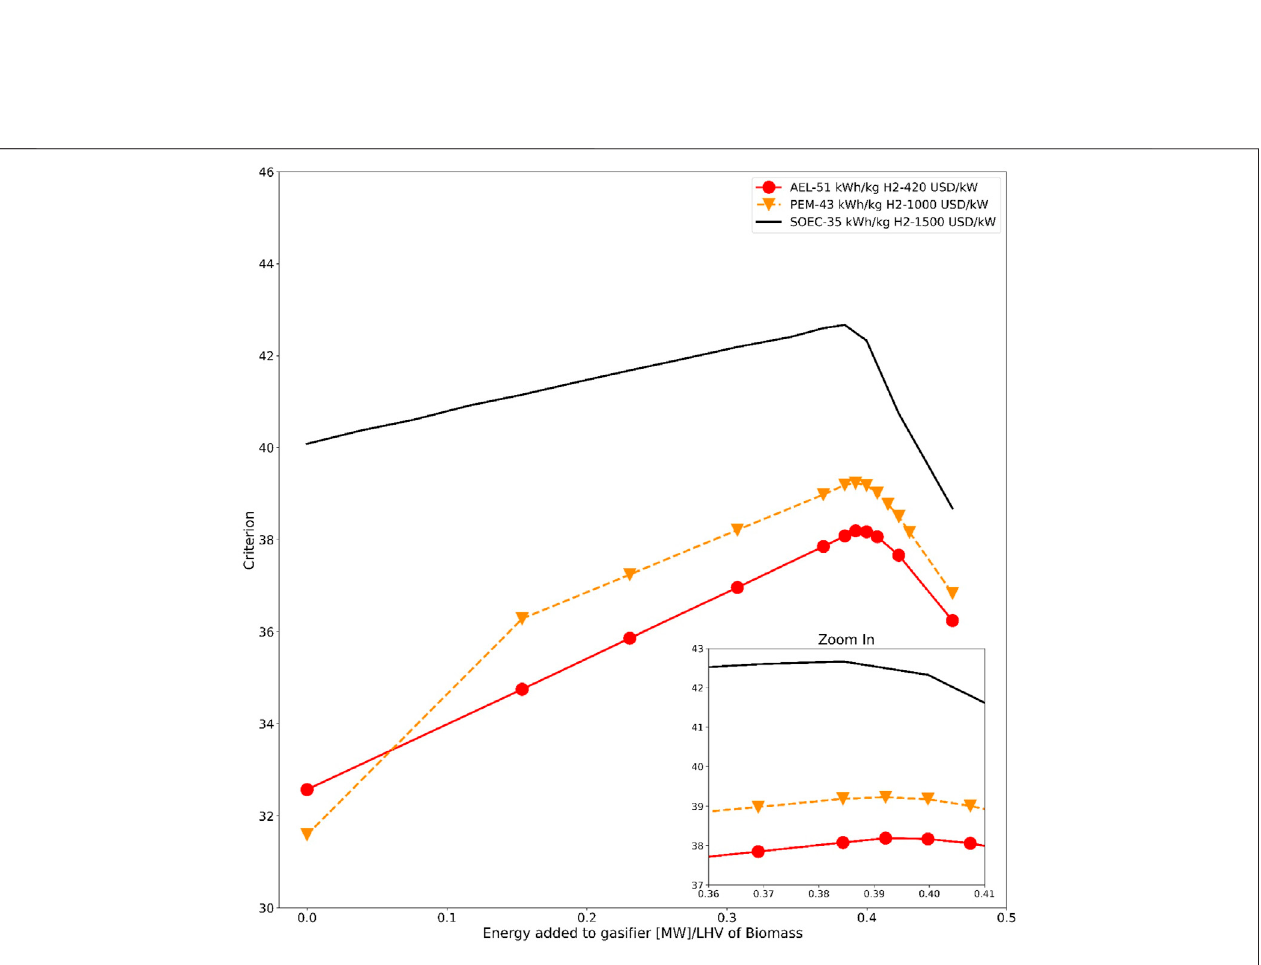
Frontiers in Energy Research |